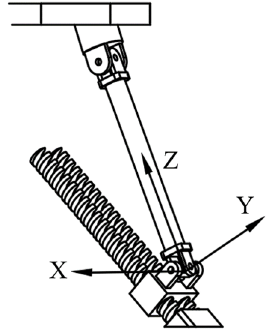
Figure 6. Coordinate system of third branch chain of 3PUU moving part.